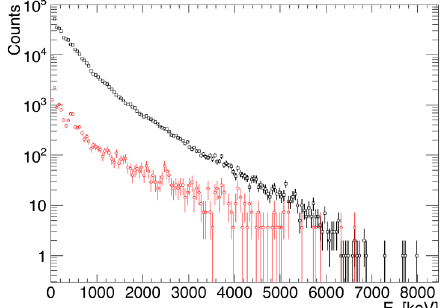
Fig. 5. Prompt fission gamma rays detected from 235 U thermal neutron-induced fission in ~2 hours-long measurement at the UML research reactor operating at 200 kW. The spectrum is obtained by gating on the prompt fission neutron events in stilbene detectors and for the coincidence window width of 25 ns. Background spectrum obtained from measurement with the Al plate is shown using open red squares.